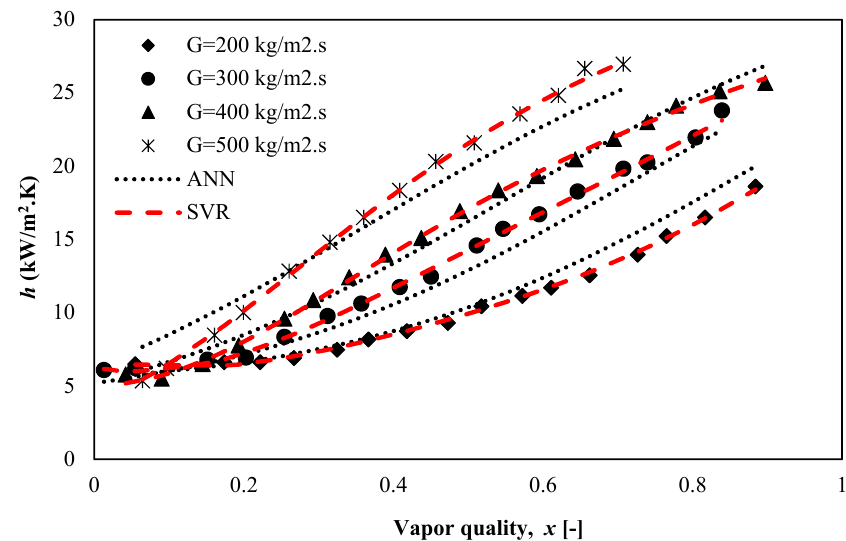
Figure 8. Observed and modeled heat transfer coefficient for R600a in a mini-channel at different mass fluxes ( q = 45 kW/m 2 ; T sat = 31 °C).